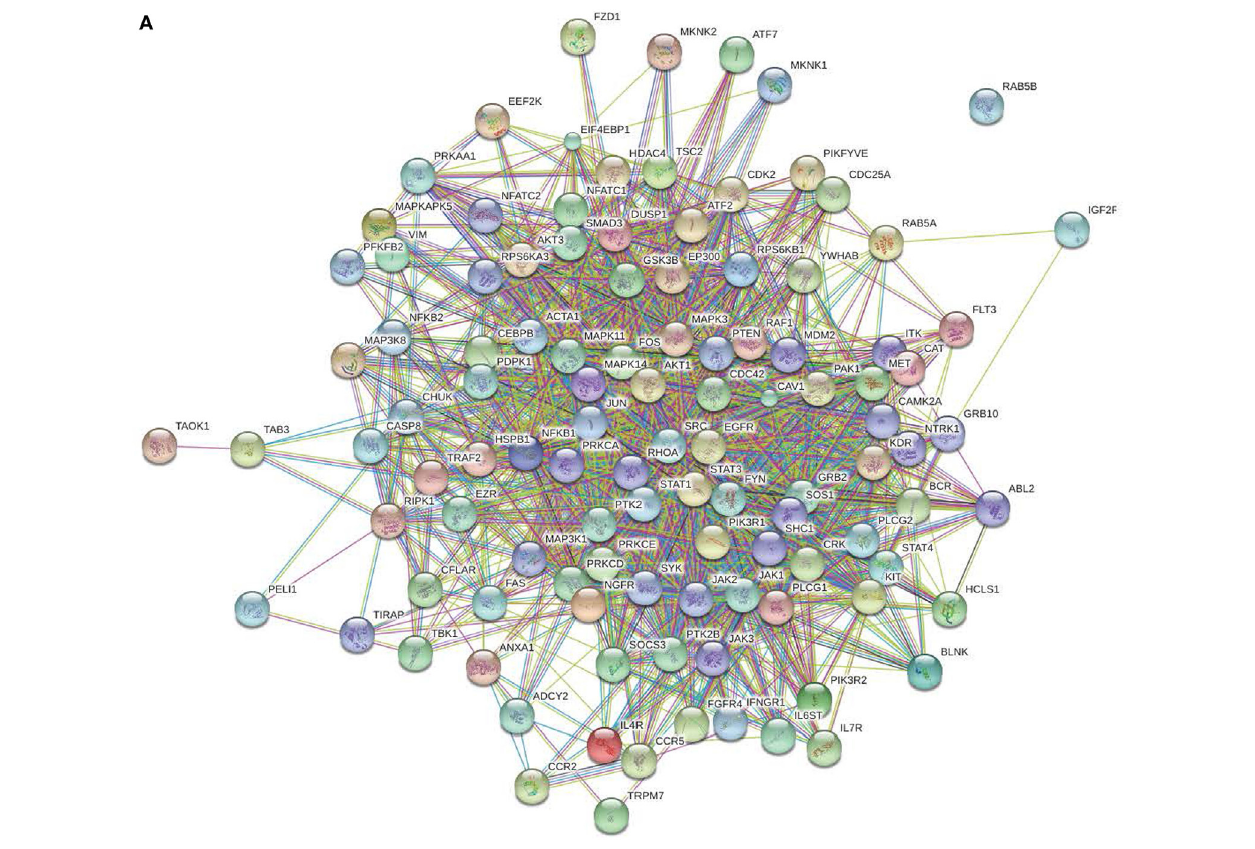
FigUre 2 | Protein–protein interactions. Predicted protein–protein interactions generated following analysis of significantly different peptides input into the STRING database: (a) early low interactions.